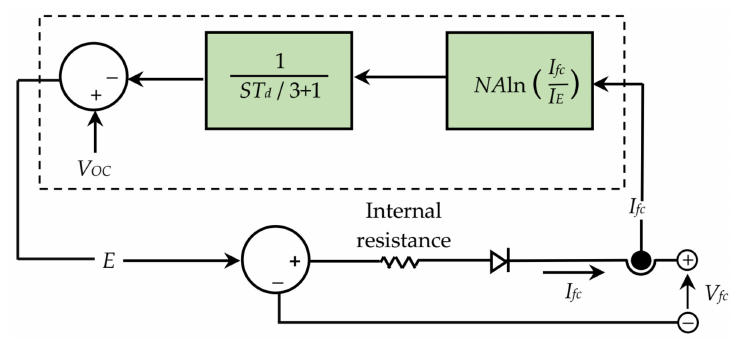
Figure 3. Equivalent circuit diagram of the PEMFC.